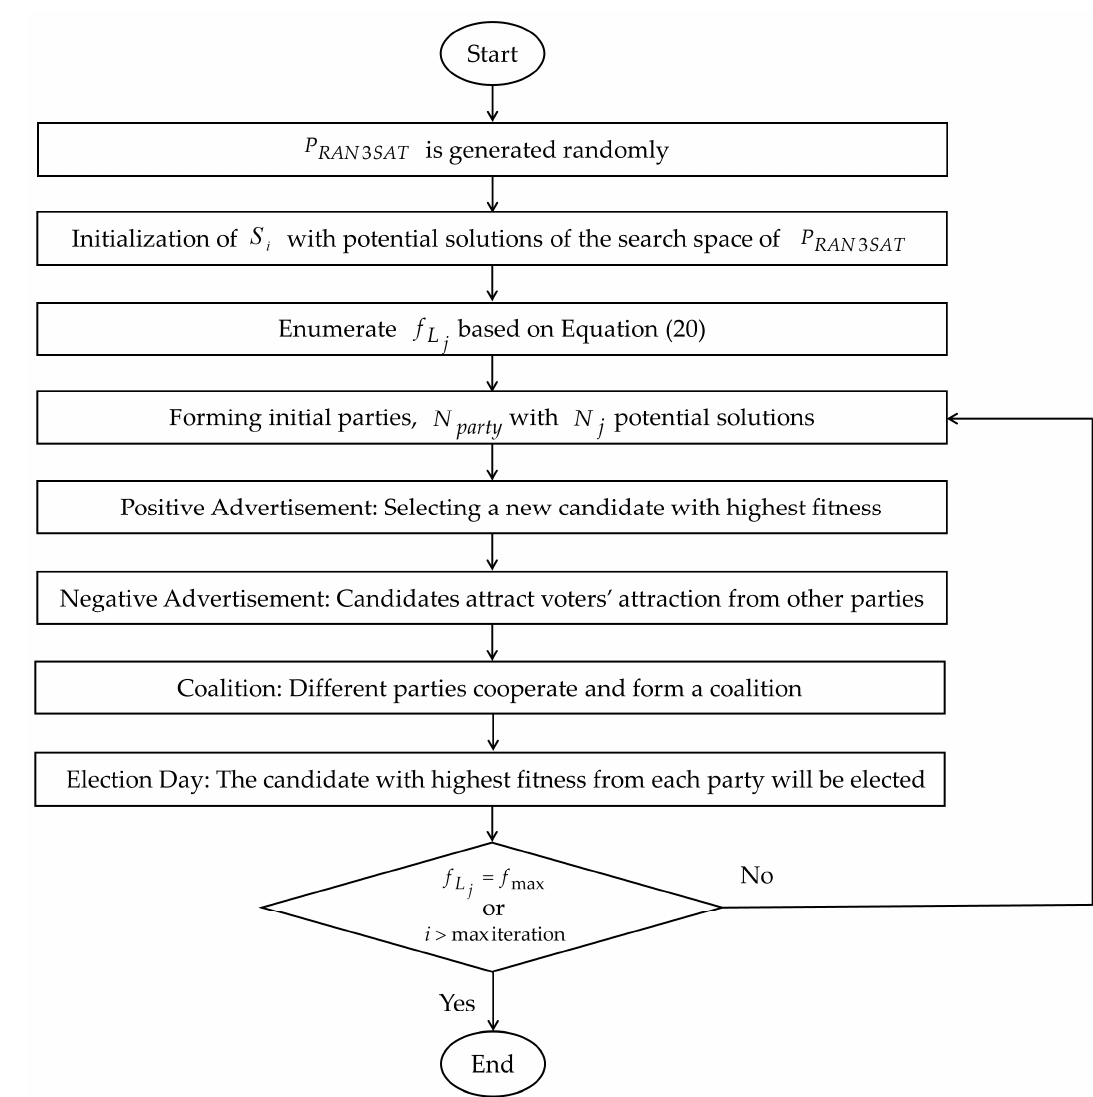
Figure 2. Flowchart of the mechanism of EA for P RAN 3 SAT . Table 1. Pseudo code of the Proposed HNN-RAN3SATEA. Algorithm: Pseudo Code of the Proposed HNN ‐ RAN3SATEA